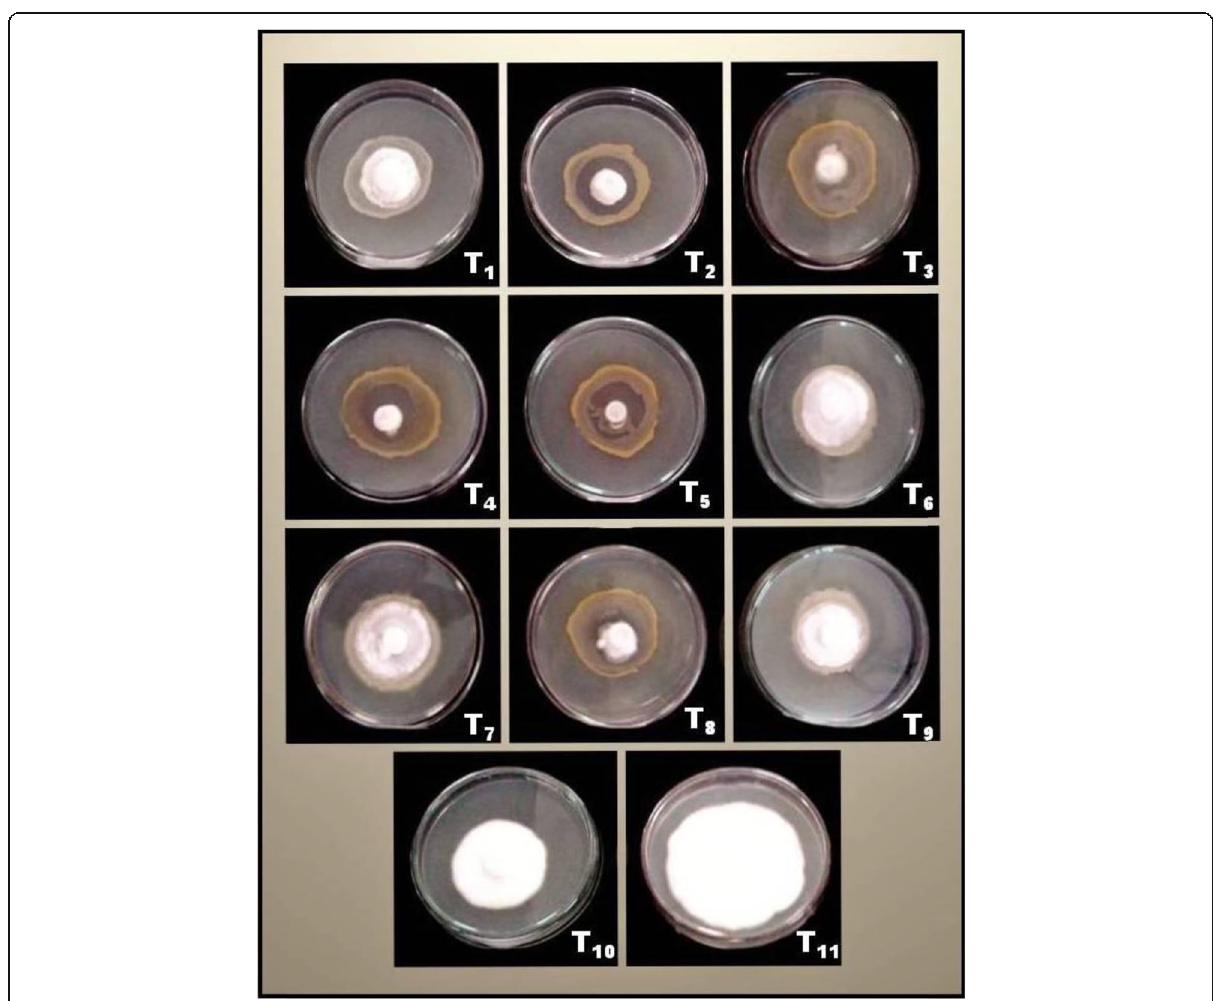
Fig. 1 Antagonism among 10 isolates of Pseudomonas fluorescens ( Pf ) and Fusarium oxysporum f. sp. cumini ( Foc ) at 6 days after inoculation in King ’ s B + PDA (1:1) medium. (T1 = Pf -1 × Foc ; T2 = Pf -2 × Foc ; T3 = Pf -3 × Foc ; T4 = Pf -4 × Foc ; T5 = Pf -5 × Foc ; T6 = Pf -6 × Foc ; T7 = Pf -7 × Foc ; T8 = Pf -8 × Foc ; T9 = Pf -9 × Foc ; T10 = Pf -10 × Foc ; T11 = Control − Foc